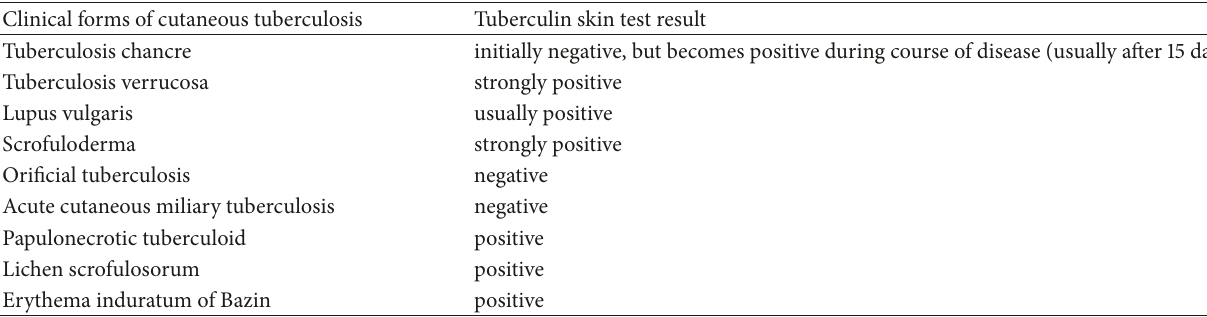
Table 2: TST result in different forms of cutaneous tuberculosis. Clinical forms of cutaneous